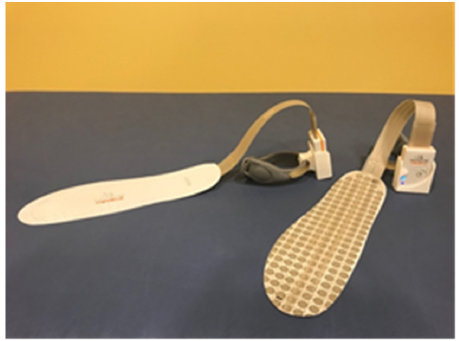
Figure 1. Sensorized insoles.